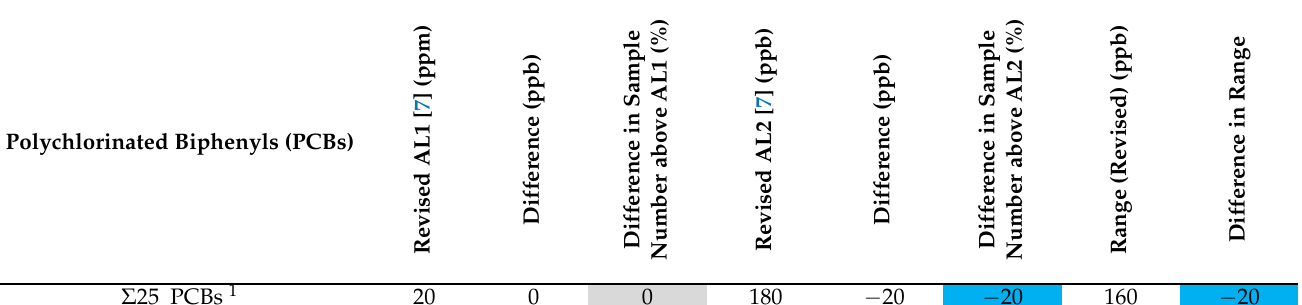
Table 14. Polychlorinated biphenyls (PCBs)—Summed PCBs— Σ 25_PCBs—Difference (revised − current) in the percentage of samples below AL1; above AL2 for revised ALs and range of values between AL1 and AL2. Please note values (green) are more protective and values (orange) are more permissive (colour codes defined in Tables 1 to 3).